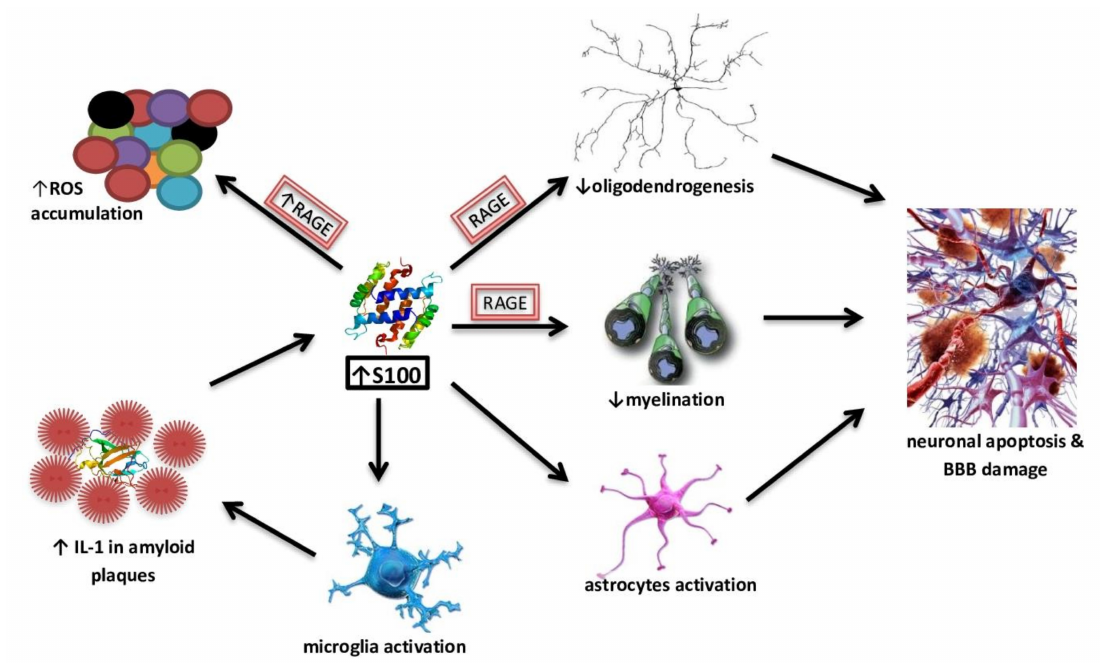
Figure 2. The e ff ect of S100B high concentrations on neurodegeneration